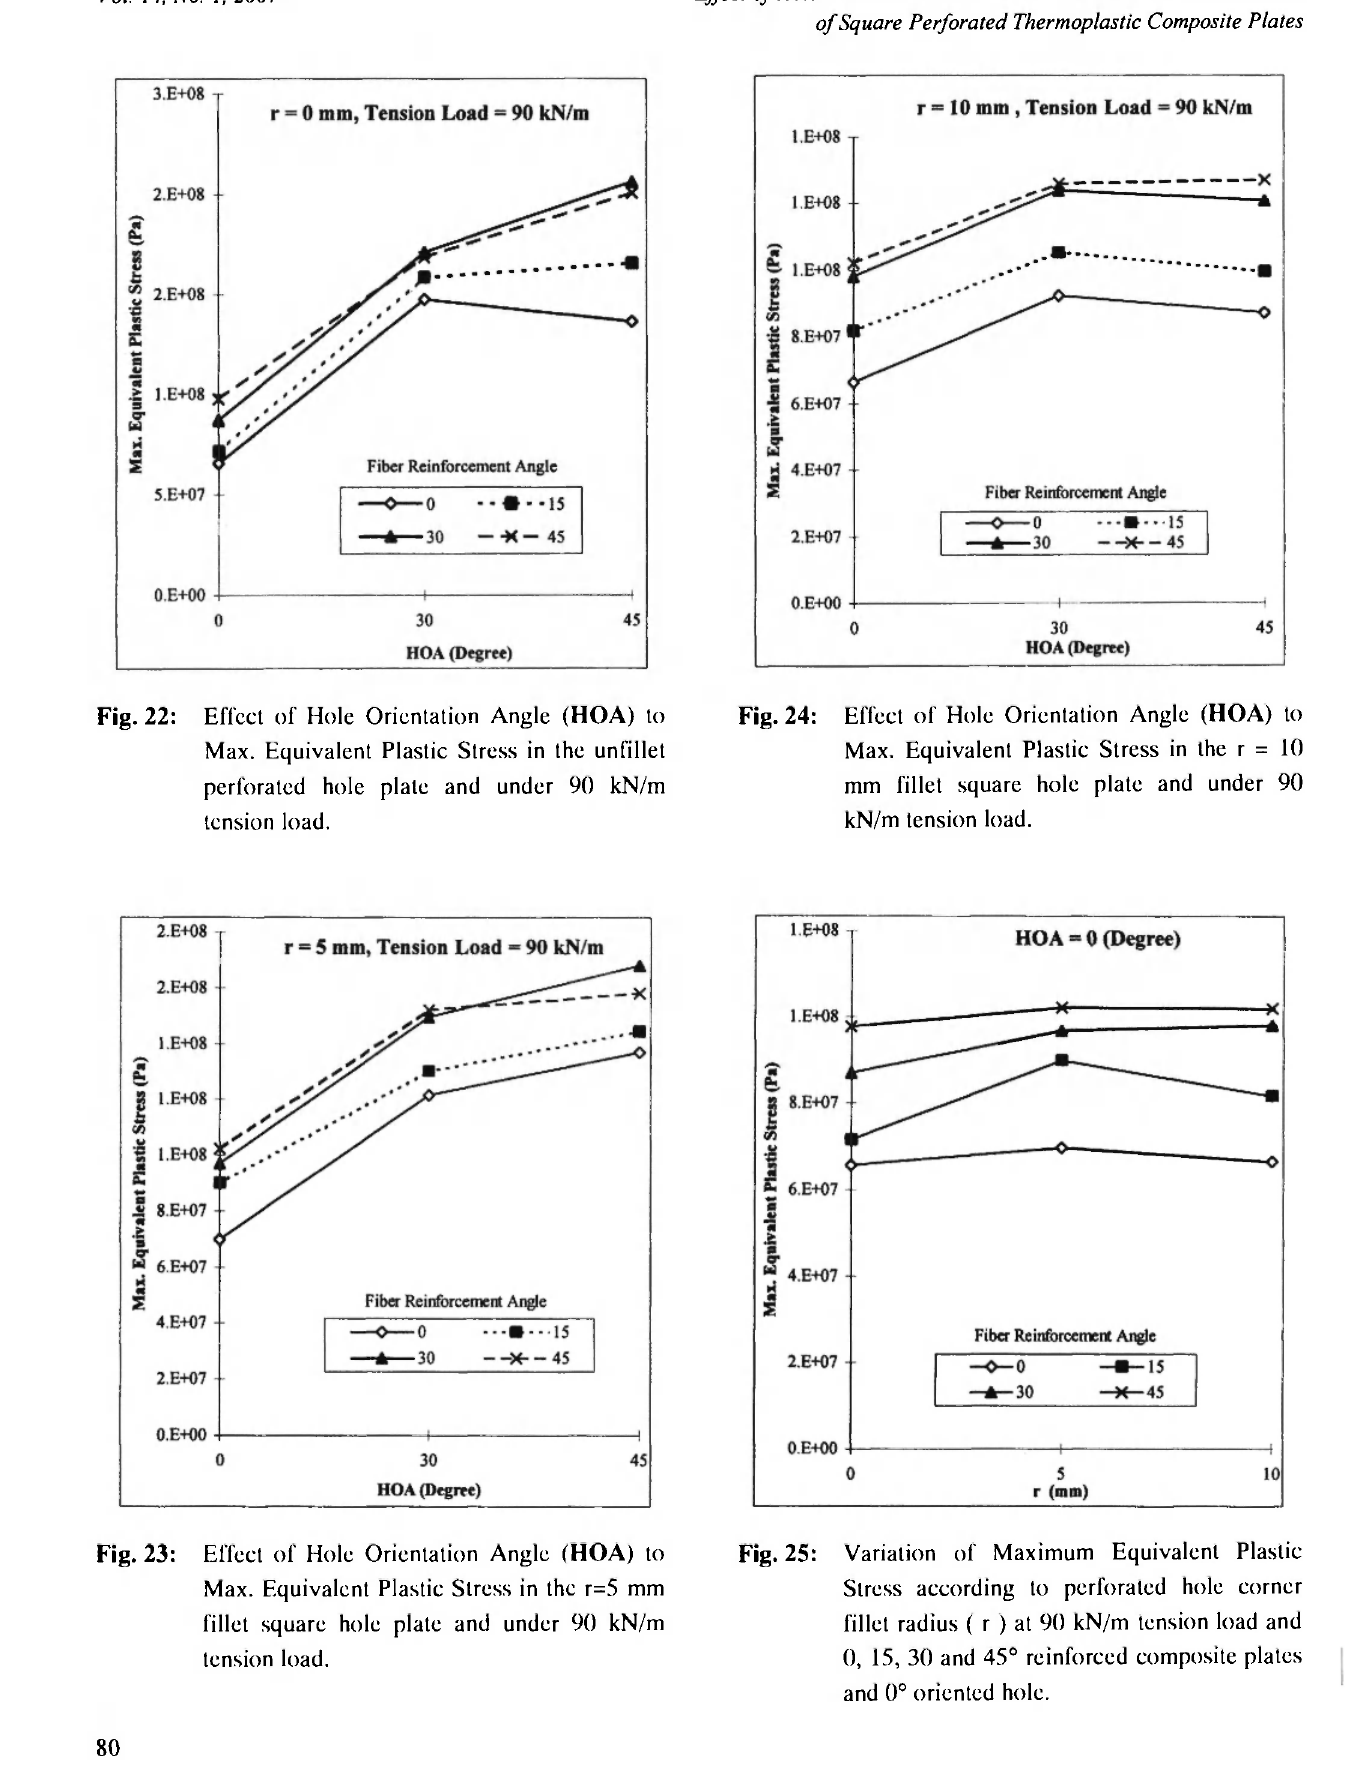
Fig. 23: Effect of Hole Orientation Angle (HOA) to Max. Equivalent Plastic Stress in the r=5 mm fillet square hole plate and under 90 kN/m tension load.